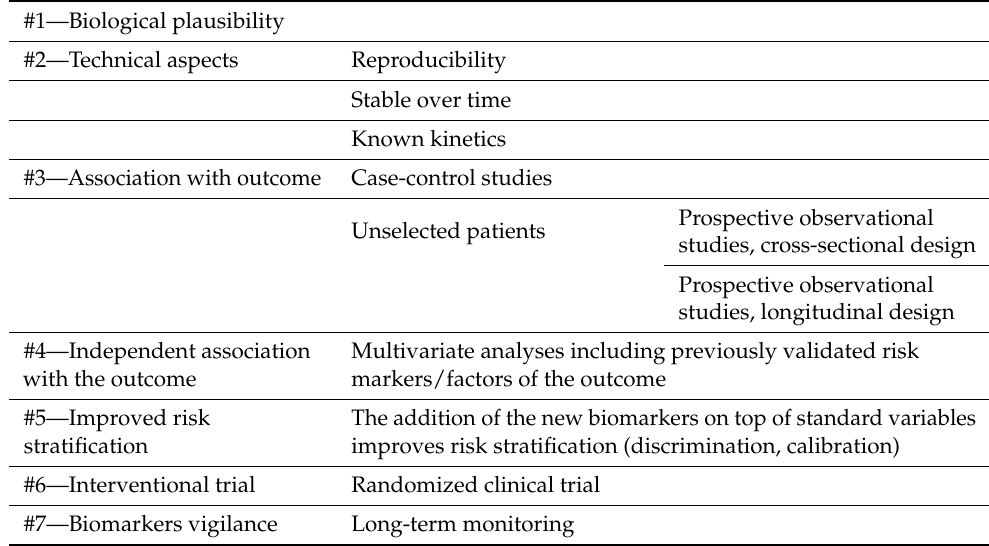
Table 1. Proposed steps to develop and validate a non-invasive biomarker of allograft